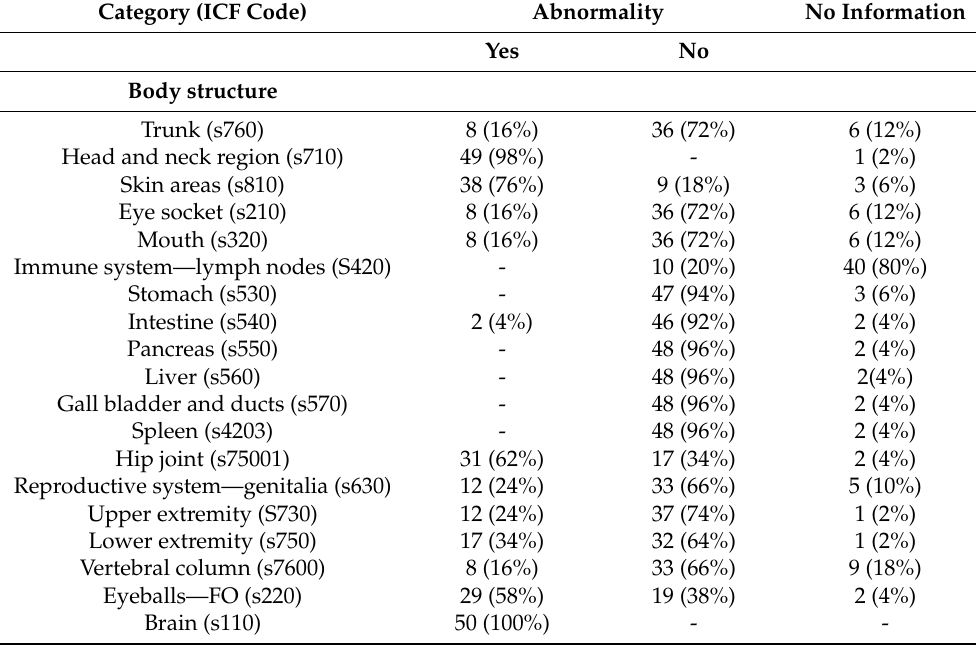
Table 2. Characterization of body structure and functional impairments in preschool aged children with CZS (n =